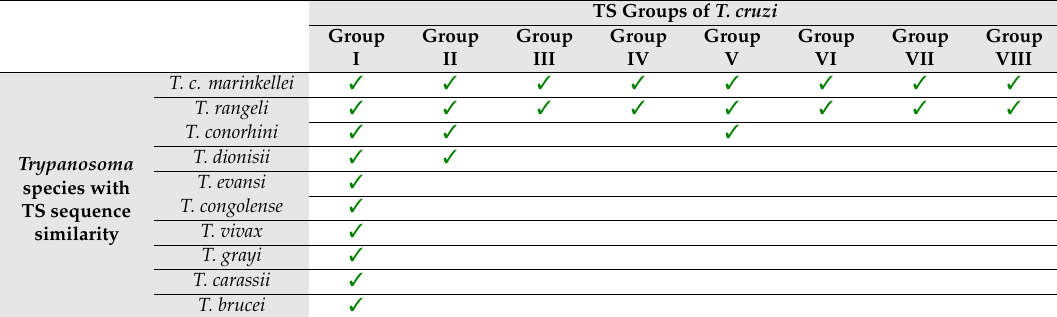
TS Groups of T. cruzi